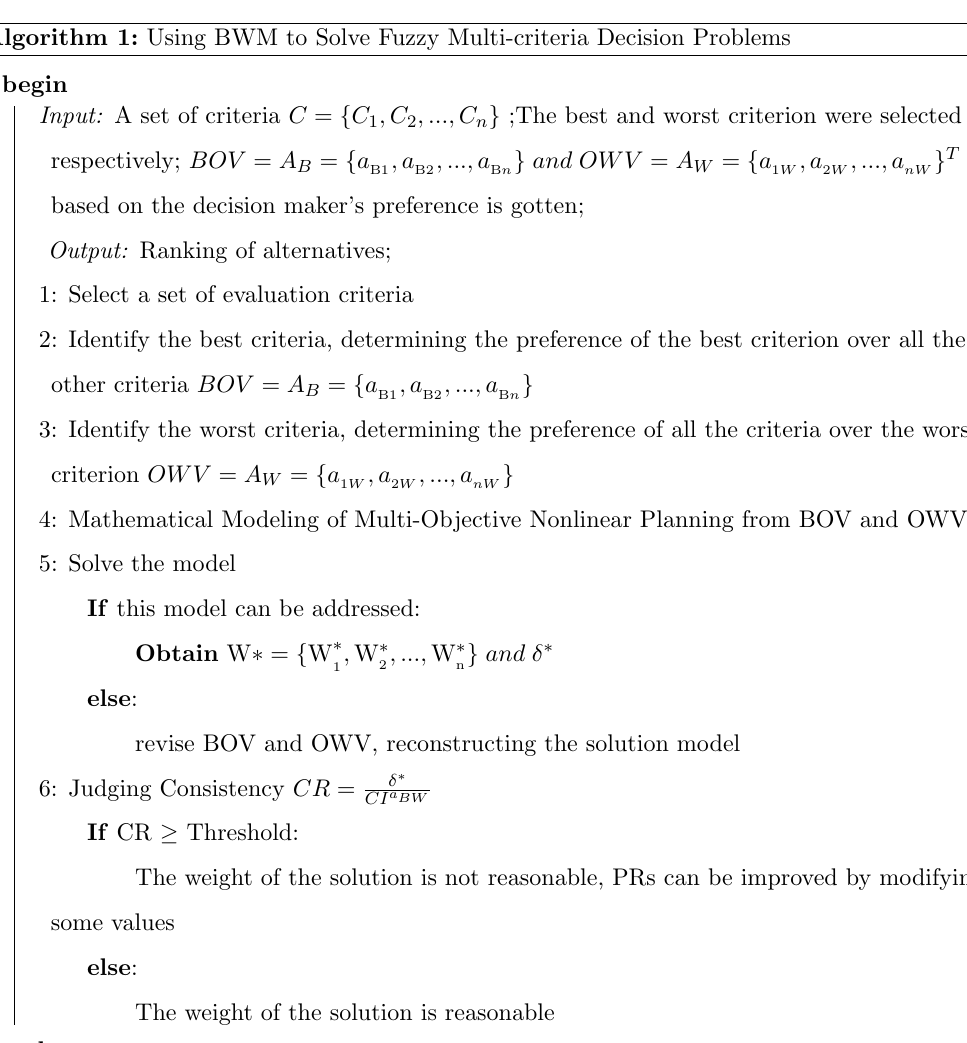
Algorithm 1: Using BWM to Solve Fuzzy Multi-criteria Decision